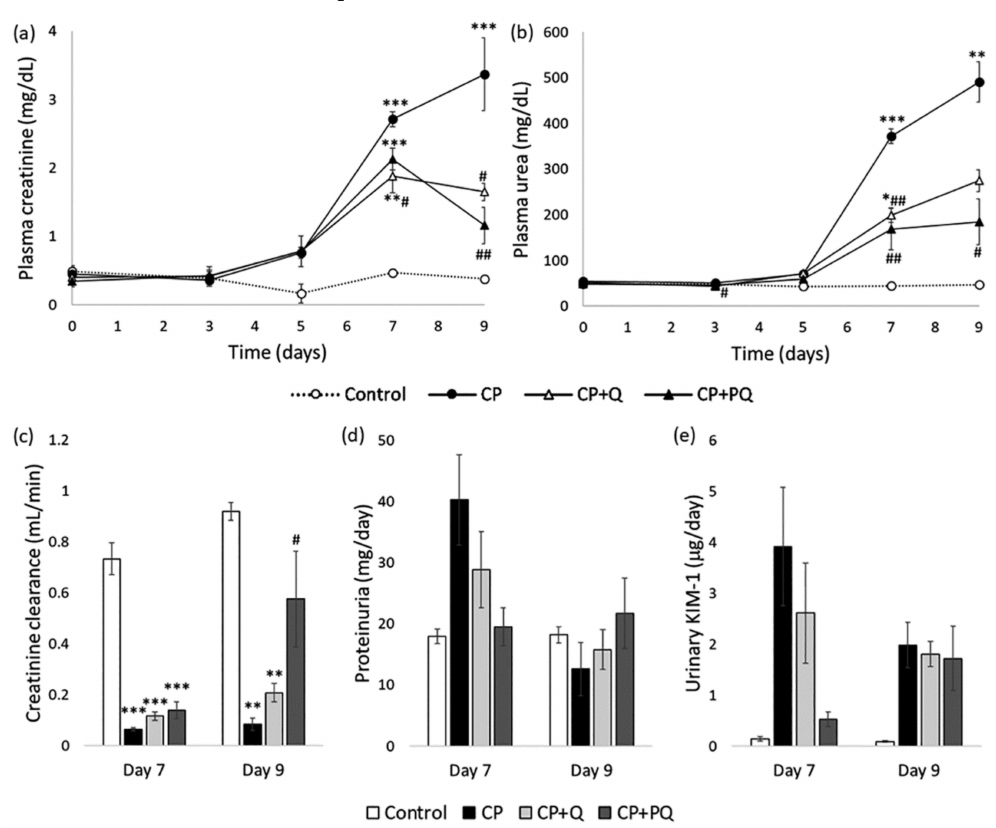
Figure 3. Evolution of renal parameters. ( a ) Plasma creatinine concentration; ( b ) Plasma urea concentration; ( c ) Creatinine clearance; ( d ) Proteinuria; and ( e ) KIM-1 urinary excretion. Values are expressed as the mean ± SEM ( n = 3–5 per group). * p < 0.05; ** p < 0.01; *** p < 0.001 vs. Control group. # p < 0.05; ## p < 0.01 vs. CP group. CP: cisplatin (6.5 mg/kg, i.p.) on day 3; CP + Q: quercetin (50 mg/kg, i.p.) for 9 days and cisplatin (6.5 mg/kg, i.p.) on day 3; CP + PQ: P-quercetin (100 mg/kg, i.p.) for 9 days and cisplatin (6.5 mg/kg, i.p.) on day 3. KIM-1: kidney injury molecule